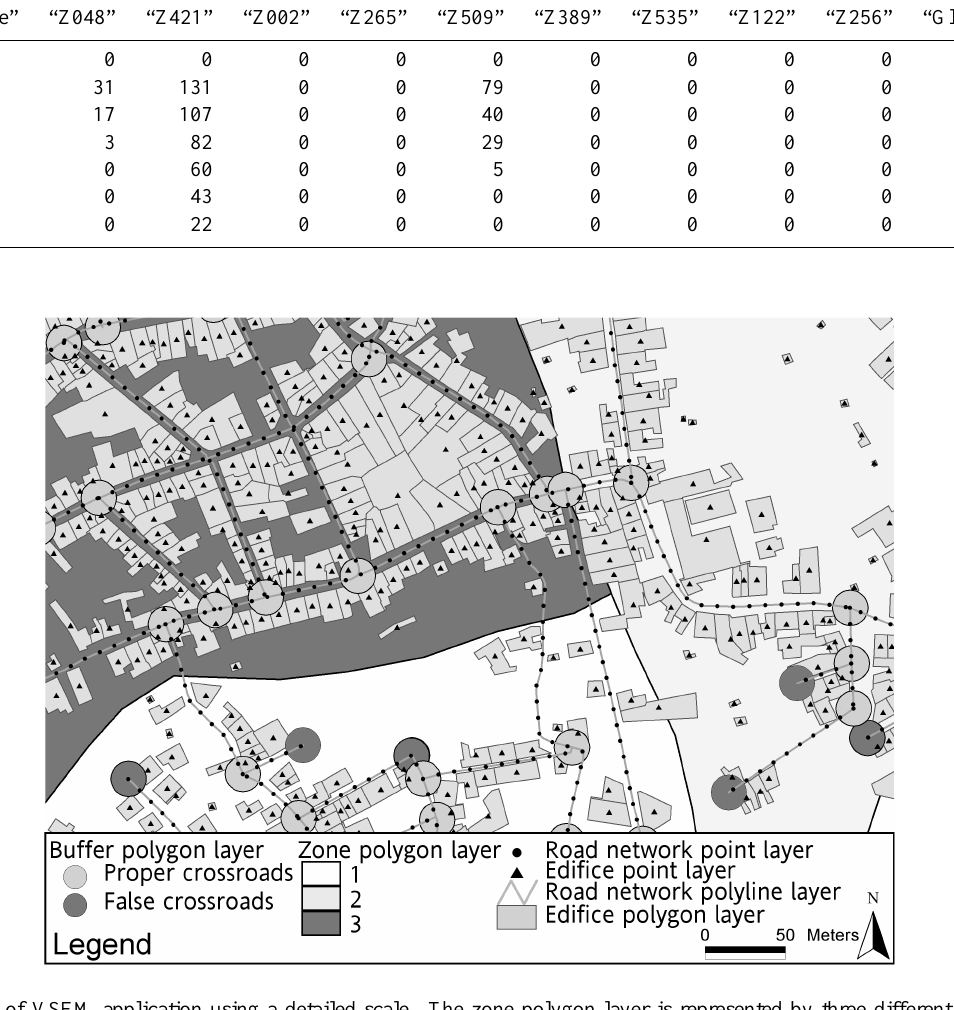
Fig. 5. Example of VSEM application using a detailed scale. The zone polygon layer is represented by three different gray tones; the buffer polyline layer is represented with two different colours, gray is a proper crossroads and dark gray is a false crossroads (end-road, superimposed, etc.). The edifice polygon layer has been transformed into a point layer (black triangles) using the centroid of each polygon. The road network polyline layer is transformed into a point layer (black circles) using a spatial homogeneous